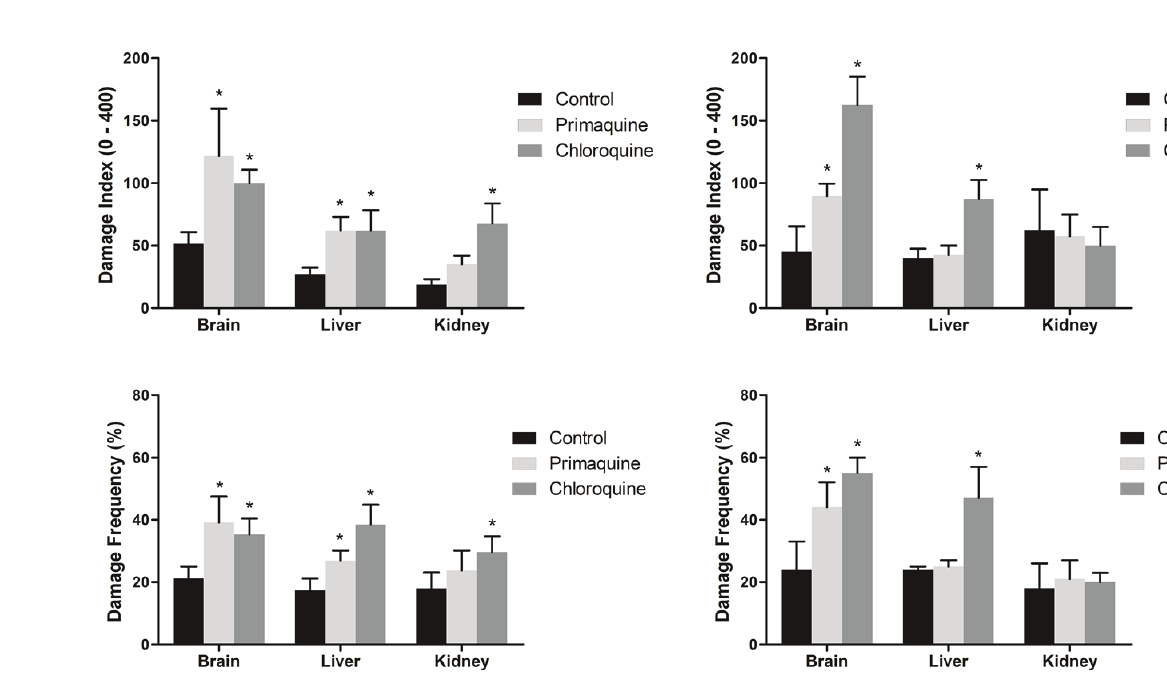
Figure 2 - Effect of 14 days of administration of primaquine and chloroquine on frequency and index of DNA damage in brain, liver and kidney of rats (n = 7 per group). Data were analyzed by one-way analysis of variances followed by the Tukey test when F was significant. Values are expressed as mean ± S.D. *p < 0.05 compared to control group.